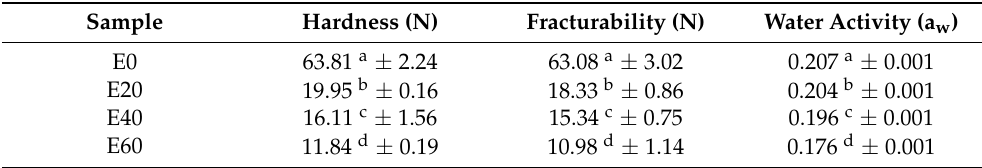
Table 4. The effect of erythritol on the textural (hardness and fracturability) parameters and water activity of the obtained